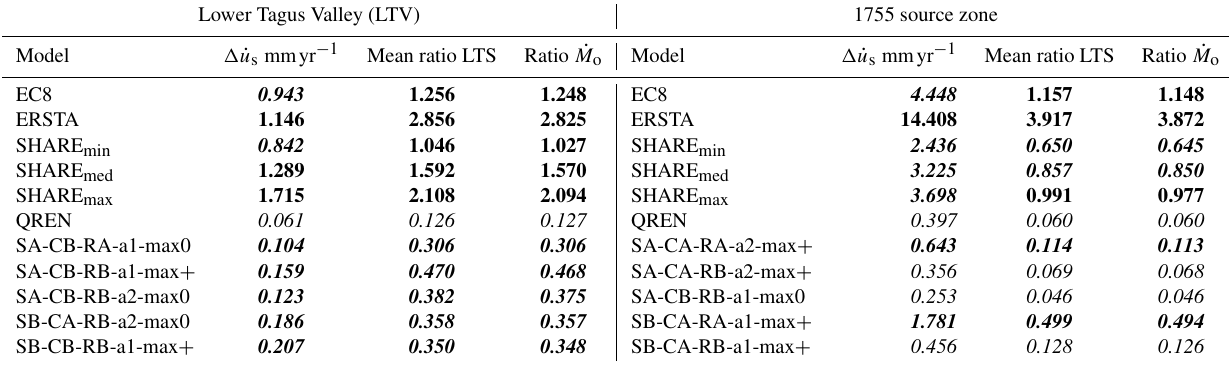
Table 12. Summary of the simple ( (cid:49) ˙ u s ) and complex (Ratio ˙ M o ) sanity tests applied to PSHA earthquake generation models. Bold indicates that the PSHA model generates too many earthquakes, while italic shows that the model generates too few earthquakes, according to criteria defined in the text. In bold and italic, we show acceptable values. Average ratios between earthquake generation are shown in the “Mean ratio LTS”